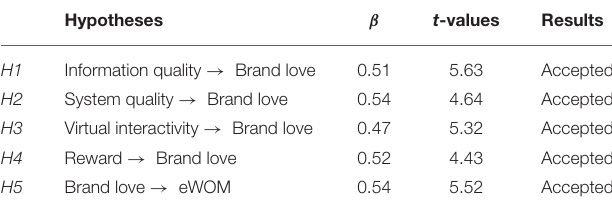
TABLE 4 | Hypotheses testing